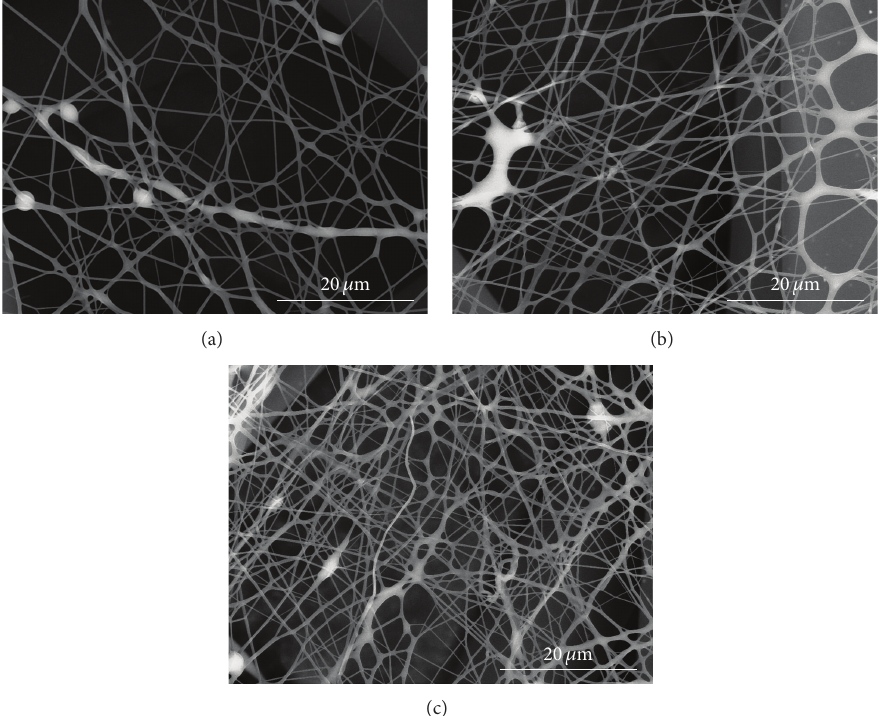
Figure 4: SEM micrographs of the (a) neat PVA fibres, (b) PVA/CNF-S 2%, and (c) PVA/CNF-F